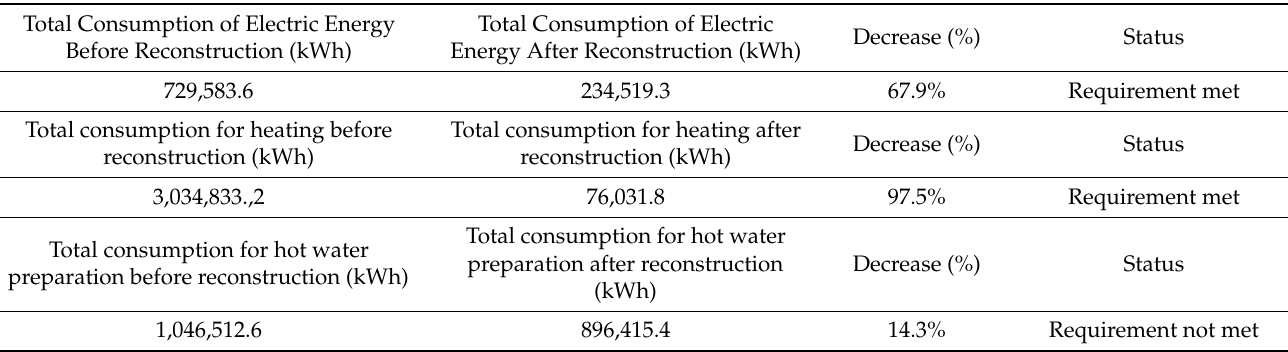
Table 28. Evaluation of the experiment in terms of energy consumption.